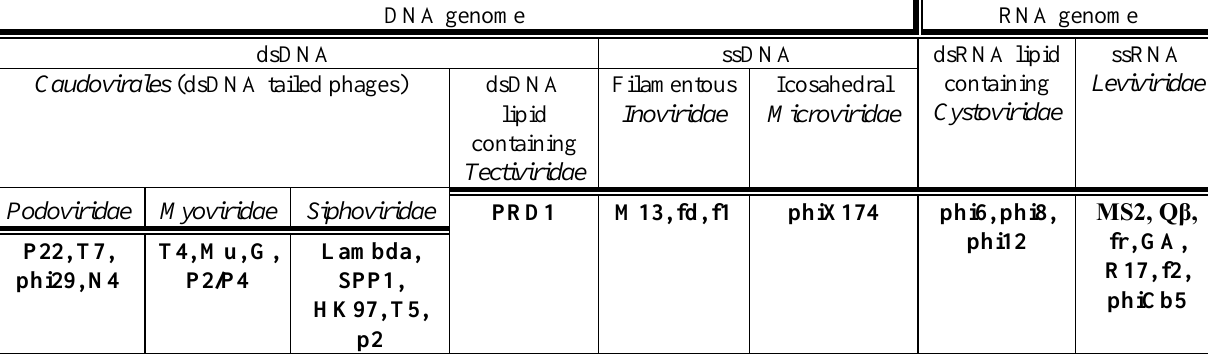
Table 1. Phages discussed in the current